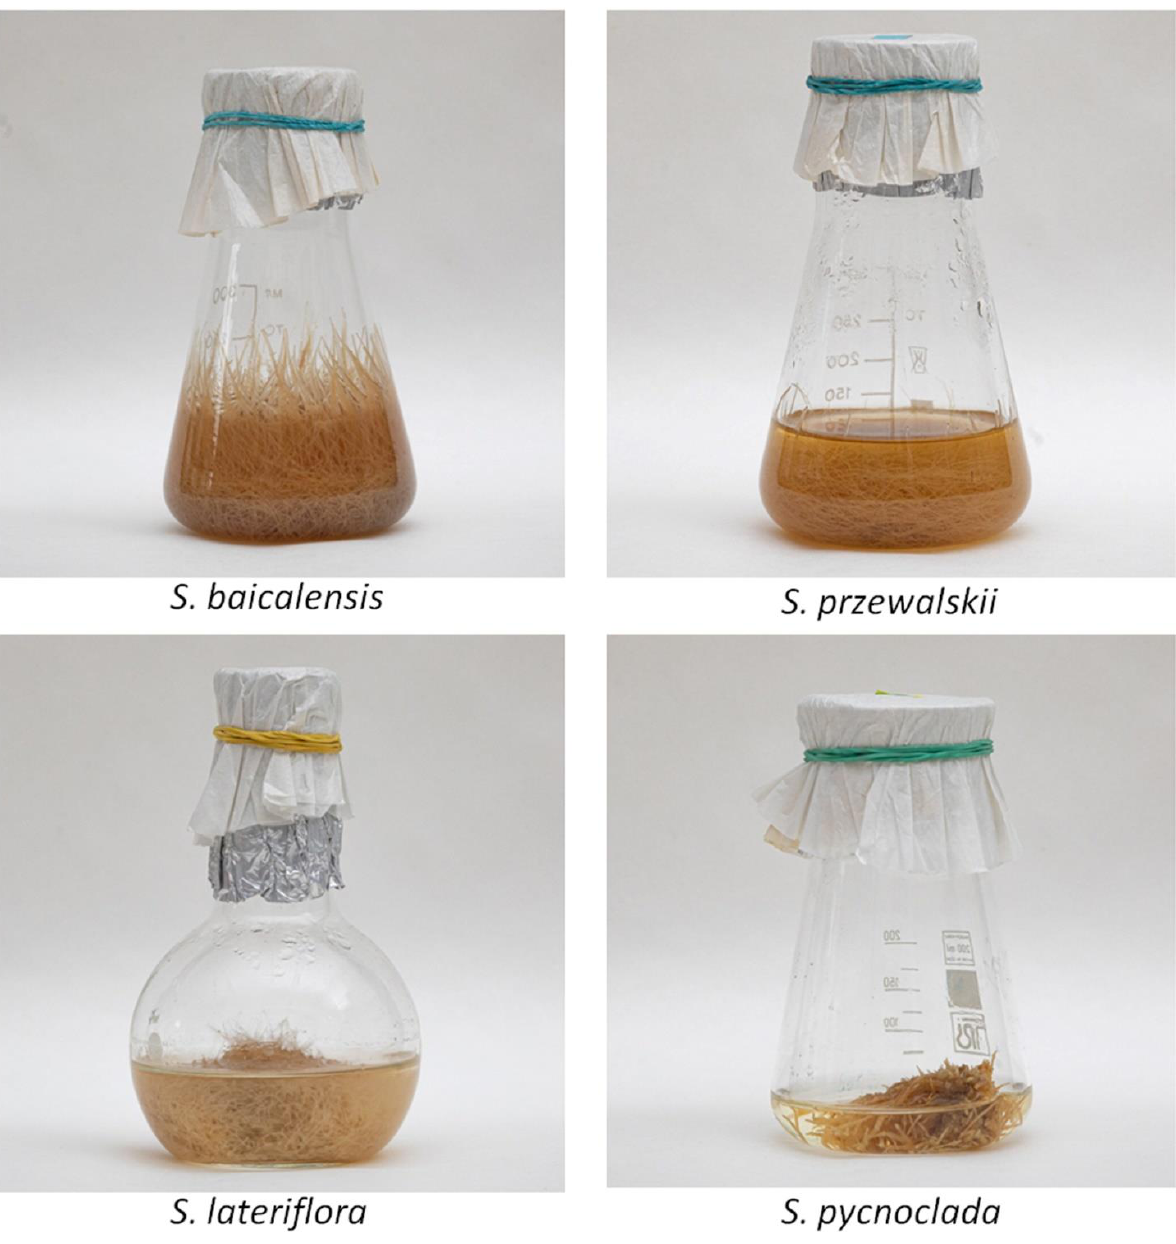
Figure 2. Growth of the hairy roots in a liquid medium.